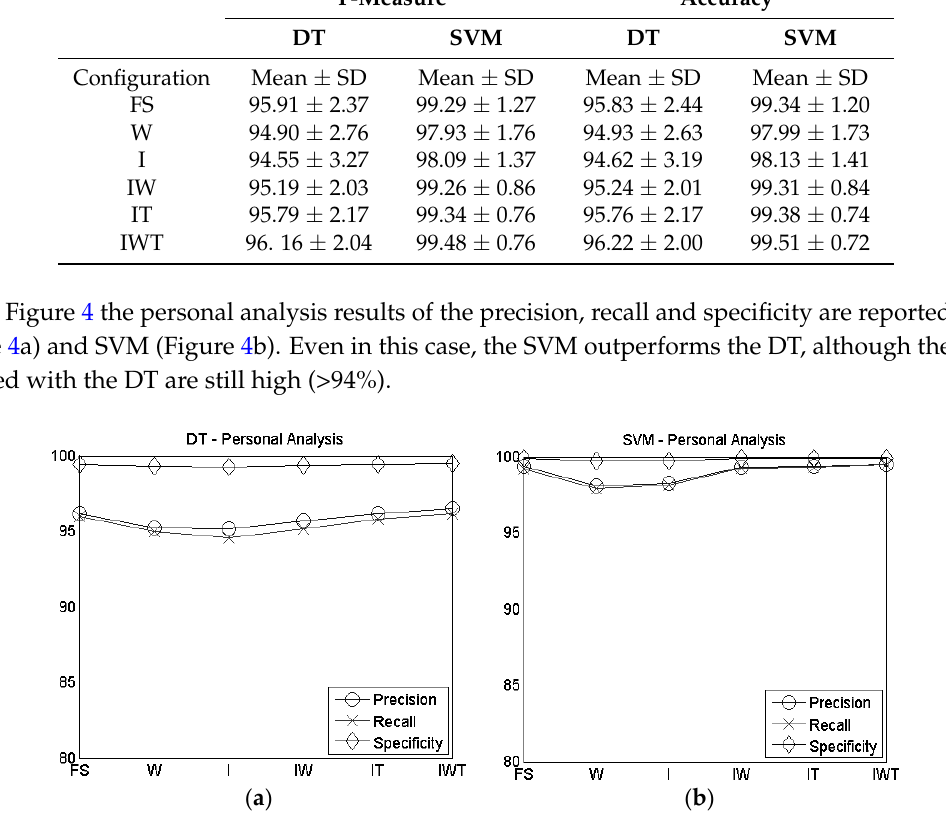
Figure 4. Precision, recall and specificity of personal analysis for ( a ) DT and ( b ) SVM.